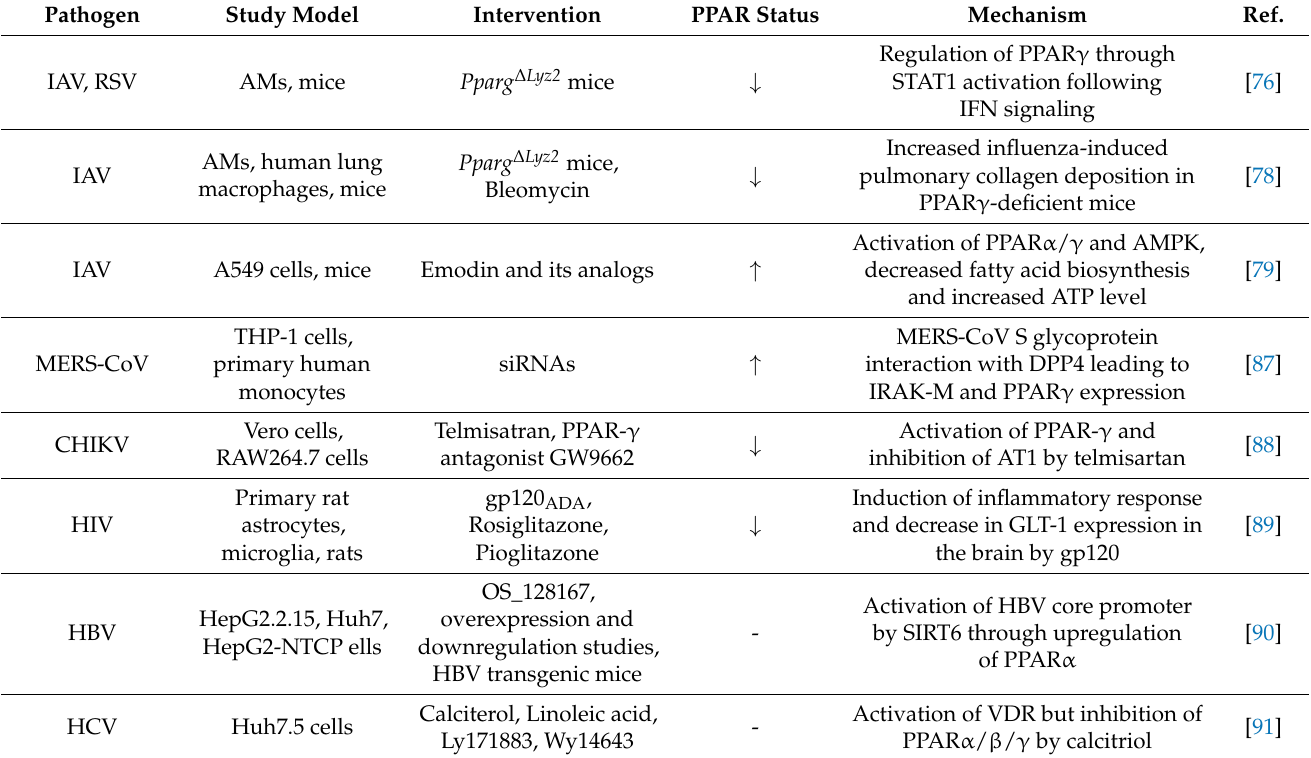
Table 1. Studies on PPARs and their ligands during viral